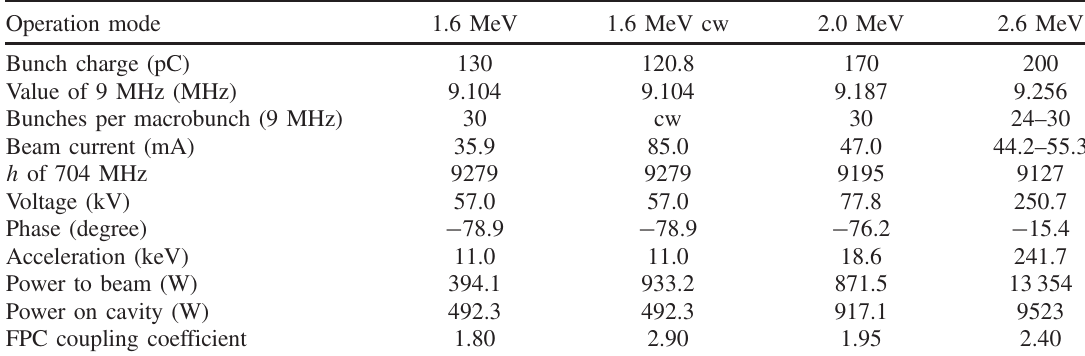
TABLE II. Requirements of the 704 MHz cavity at different operating modes.